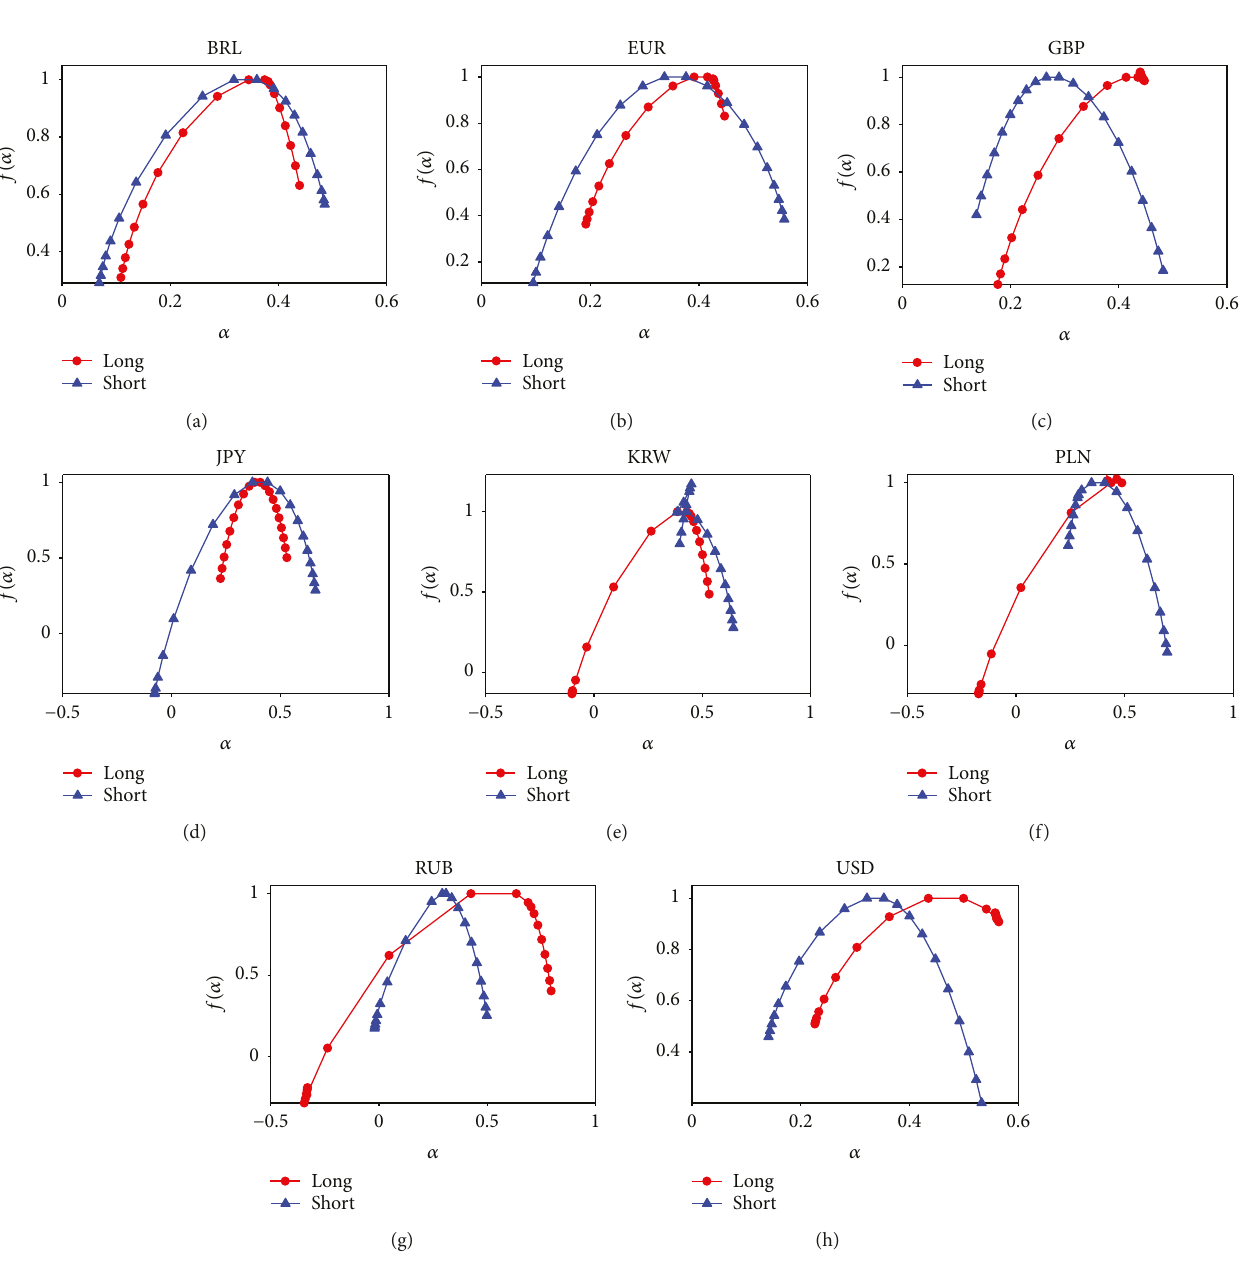
Figure 11: The long-term and short-term multifractal spectrum f